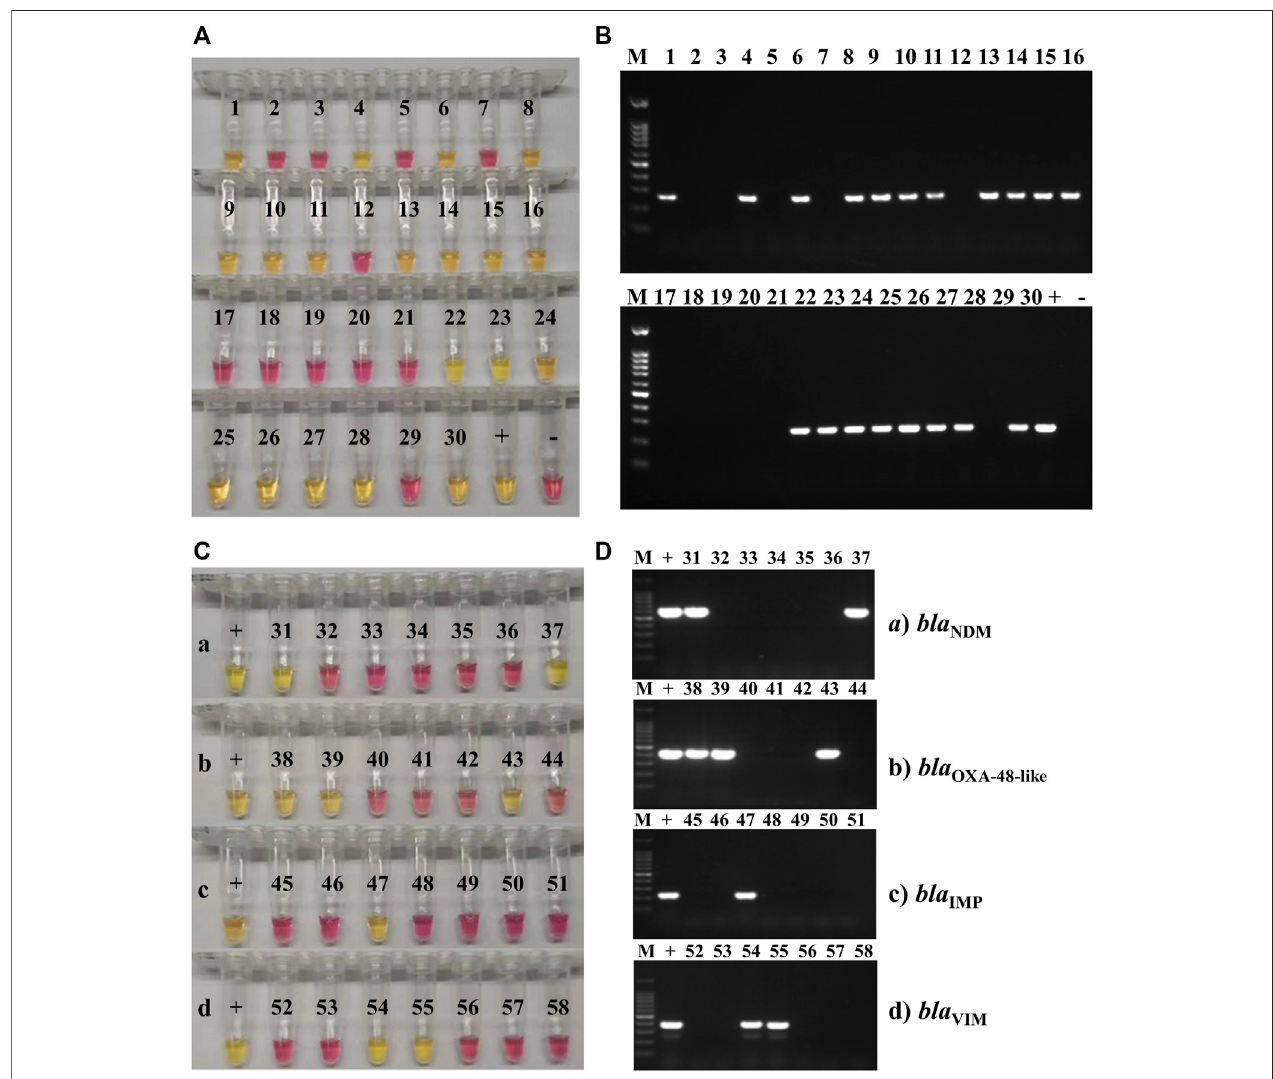
FIGURE 3 | Carbapenemase-producing genes LAMP and PCR testing on clinical isolates. (A) Representative colorimetric LAMP results targeting the bla KPC gene performedon30ofthe120clinicalisolatesof K.pneumoniae collectedatRuijinHospital(Shanghai,China);19isolateswere bla KPC -positive(yellow;1,4,6,8 – 11,13 – 16, 22 – 28, and 30), and 11 were negative (pink). (B) Representative results of endpoint PCR targeting the bla KPC gene performed on the same 30 clinical isolates of K. pneumoniae than the ones tested by LAMP. Nineteen isolates were bla KPC -positive (ampli fi cation band at 240 bp; 1, 4, 6, 8 – 11, 13 – 16, 22 – 28, and 30), and 11 werenegative (noampli fi cation band). Themarker(M)used fortheseexperiments wasa100-bp DNA ladder. (C) RepresentativecolorimetricLAMP results targeting the